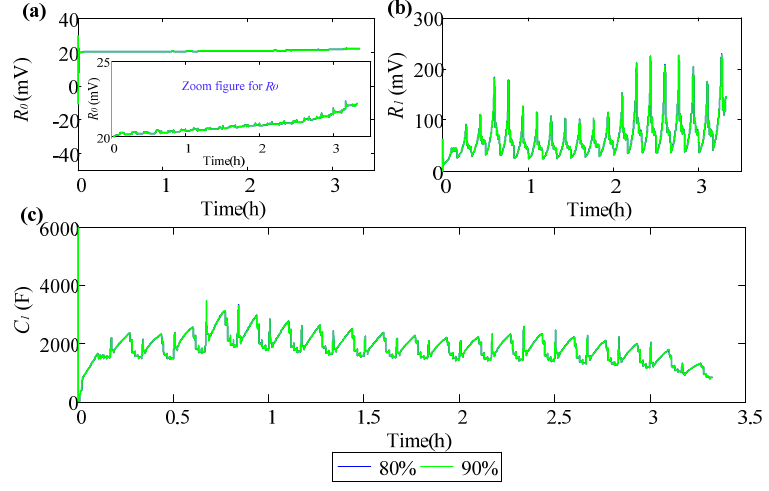
Figure 11. Model parameter identification results of the LiFePO 4 cell: ( a ) R 0 ; ( b ) R 1 ; ( c ) C 1